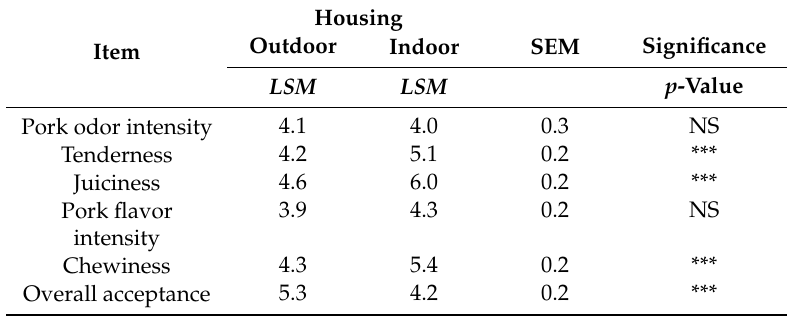
Table 7. Organoleptic properties of grilled longissimus lumborum